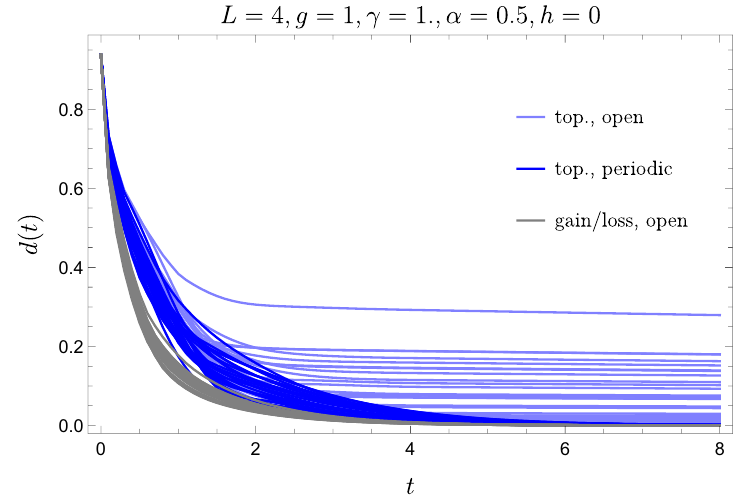
Figure 9: Comparison of the distance to equilibrium for the topological model for open and periodic boundary conditions, as well as the gain / loss model with open boundary conditions, on a system of size L = 4 and starting from randomly drawn initial states (restricted to be pure quantum states at time